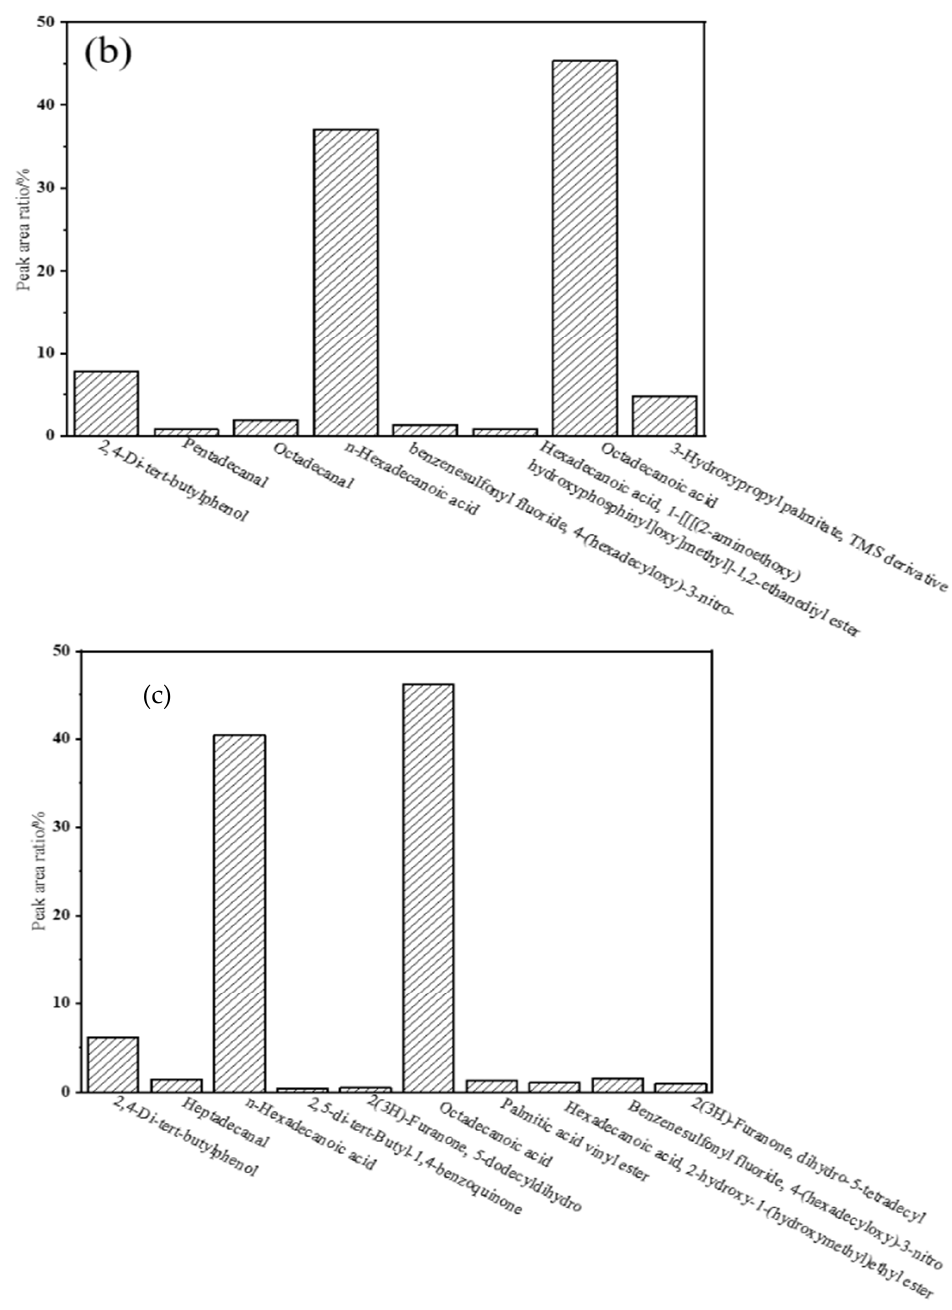
Figure 3. Composition of macromolecular organic gas pollutants during thermal desorption of simulated polluted soils under pure N 2 atmosphere at 500 ◦ C. ( a ) A1, sample of 1 mL waste oil mixed with 25 g soil; ( b ) A2, sample of 2 mL waste oil mixed with 25 g soil; ( c ) A3, sample of 3 mL waste oil mixed with 25 g soil.